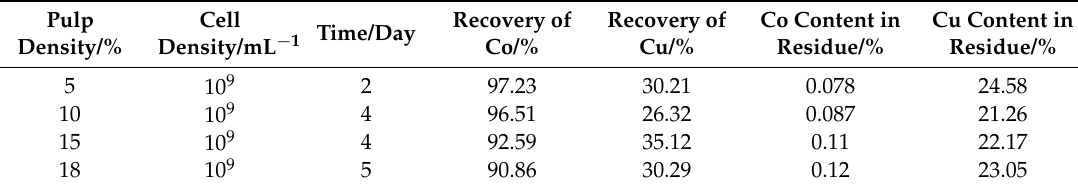
Figure 3. Effect of equilibrium pH on the recoveries of copper, cobalt, and iron ( a ) and separation factor ( b ) (A/O phase ratio = 1/1, LIX 984N concentration = 25% ( v / v ), contact time = 20 min, temperature = 25 °C).